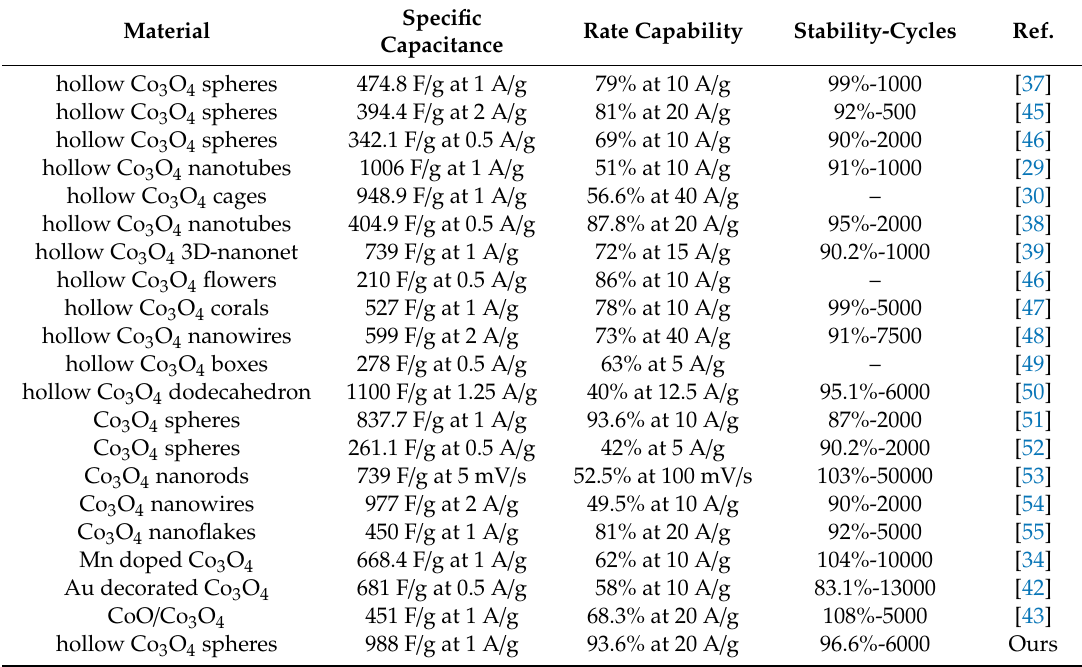
Table 1. Brief capacitance, rate, and cycling performance list of Co 3 O 4 -based electrode materials.